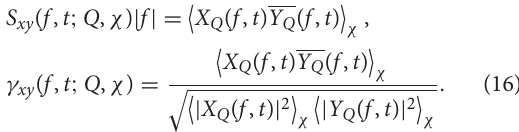
FIGURE 8 | CWT of the physiological rate signals of subject slp04 from the database slpdb , computed as the real and imaginary parts of Equation (8). (A) Surrogate K θ signal of (B) R , the amplitude modulation in the θ band, (C) amplitude modulation in the β − γ band R frequency modulation in the respiration signal K Resp I . The color codes for the amplitude (twice the modulus) of the CWTs, computed with the Grossmann wavelet of quality factor Q 5. The amplitude has the unit of the signal: no dimension in (A–C) , in radian per second in (D,E) . At the top row, the hypnogram is marked with red = dots corresponding to annotated events of obstructive apnea with